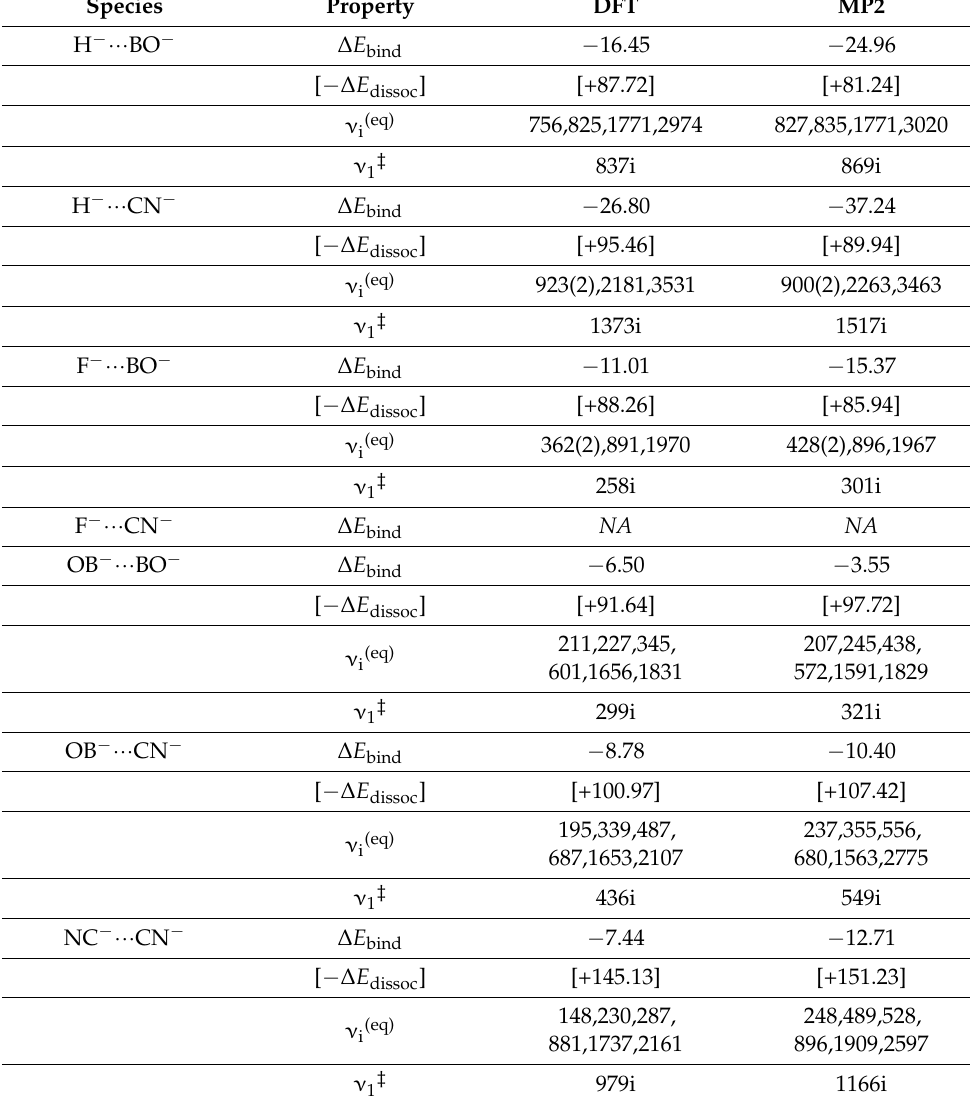
Table 2. Calculated equilibrium well depth ( ∆ E bind , kcal/mol), ionic dissociation energy ( ∆ E dissoc